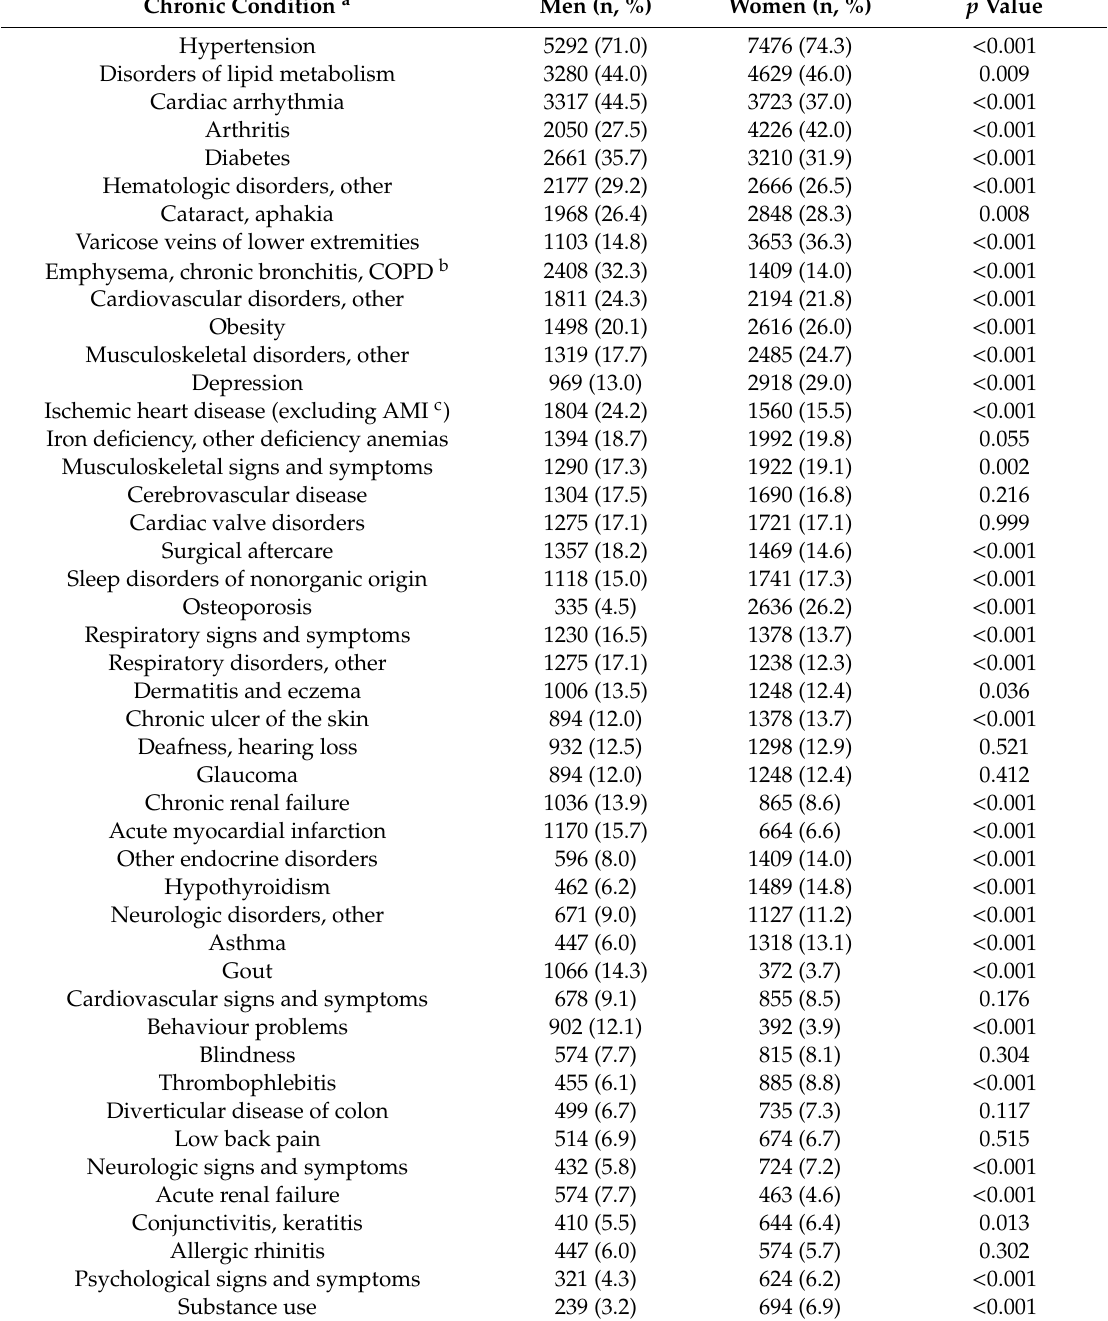
Table 2. Di ff erences in the comorbidity profile of men ( n = 7454) and women ( n = 10,062) with heart failure. Age-adjusted prevalence of chronic comorbidities with a mean prevalence higher than 5% is